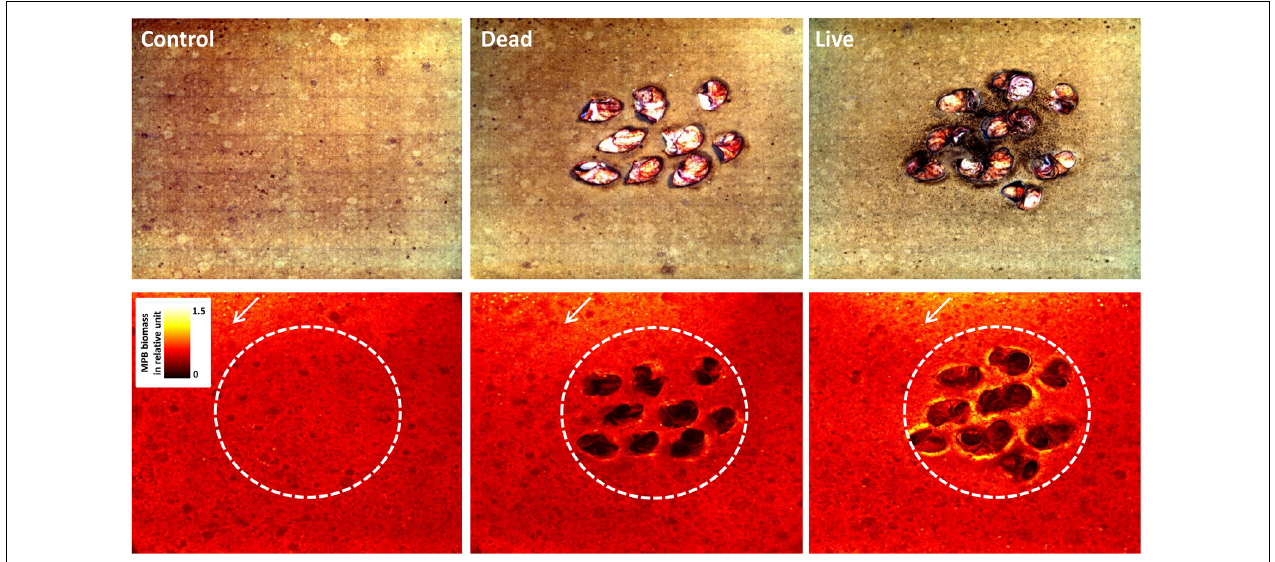
FIGURE 2 | Top view of the sediment surface after 10 days in the experimental mesocosms with the control, dead and live treatments. Shown are examples of true-color images (top row) and the corresponding Microphytobenthos (MPB) biomass maps (in relative units; bottom row). White arrows indicate overlying seawater flow direction. Dashed circles represent the inner bed sediment